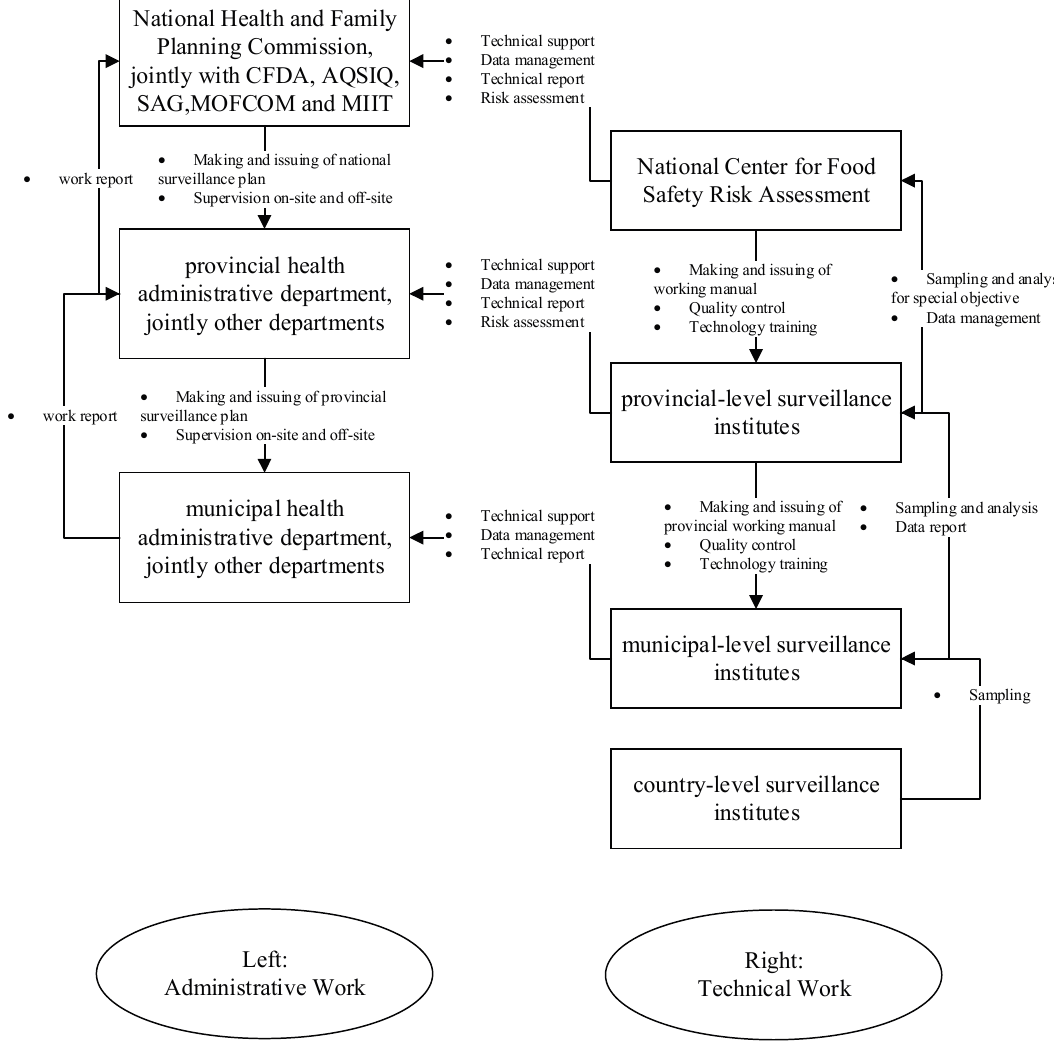
Figure 1. Flow chart of Microbiological food safety surveillance in